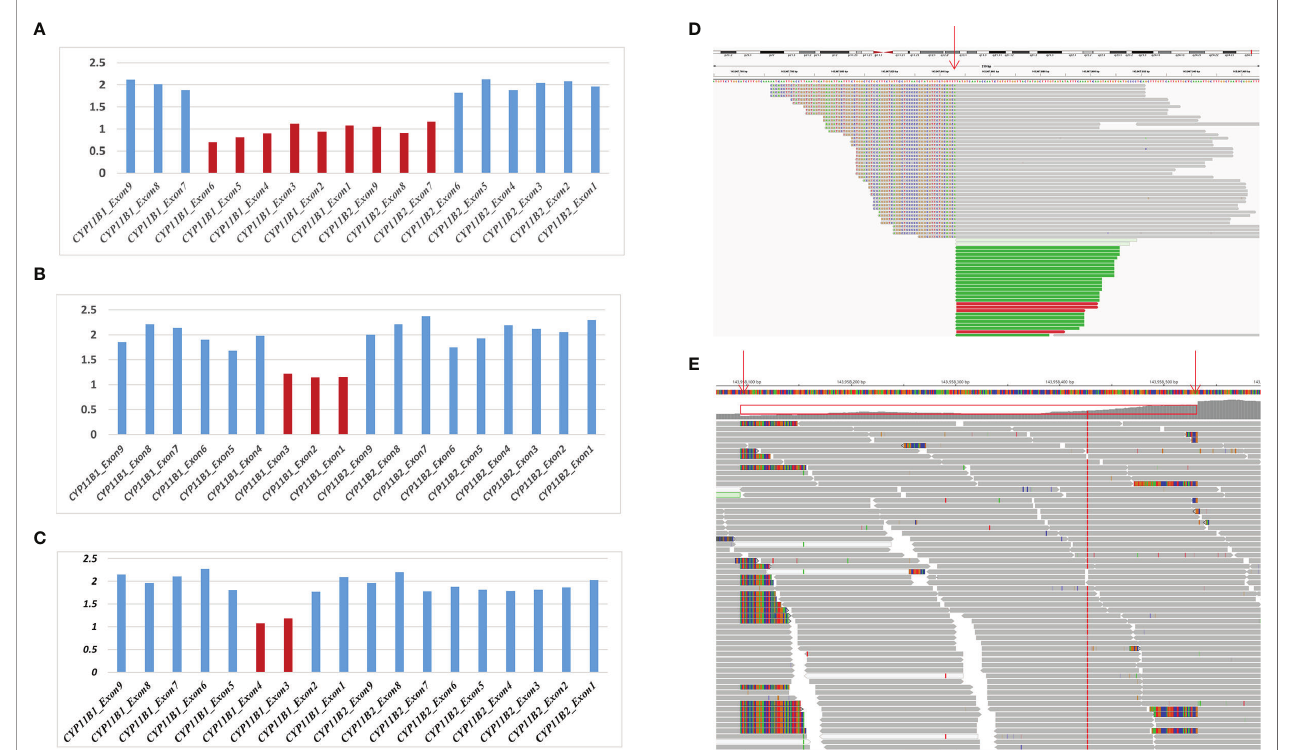
FIGURE 2 | Detection of hemizygous intergenic/intragenic deletions in target sequencing data. (A – C) Intergenic/intragenic deletions in three patients. (A) Heterozygous deletion of exons 1-6 of CYP11B1 and exons 7-9 of CYP11B2 in patient 1 suggesting the chimeric CYP11B2/CYP11B1 gene. (B) Heterozygous deletion of exons 1-3 of CYP11B1 in patient 2. (C) Heterozygous deletion of exons 3-4 of CYP11B1 in patient 3. The x -axis represents the corresponding exons in CYP11B1 or CYP11B2 . The y -axis shows the ratio of the mean coverage of the test sample to that of the control samples. (D, E) Misalignment information of split reads indicate the CYP11B1 rearrangements shown by IGV. (D) The red arrow indicates the breakpoint of chr8:143967846 in patient 2. (E) The red arrows indicate the breakpoint of chr8:143958084 and chr8:143958532 in patient